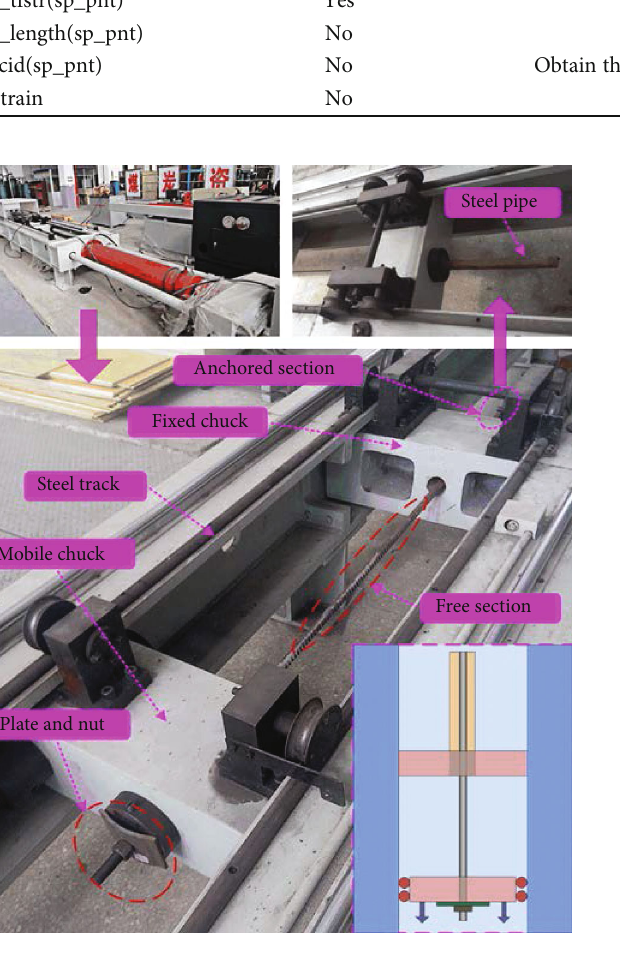
Figure 7: The pull-out test on the rock bolt performance test